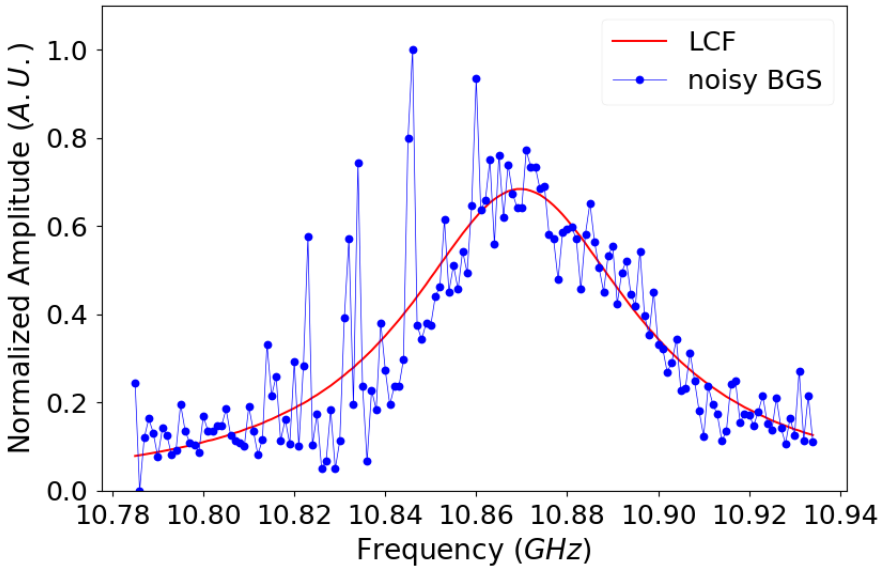
Figure 3. Fitted Lorentzian curve fitting (LCF) method on a noisy Brillouin gain spectrum